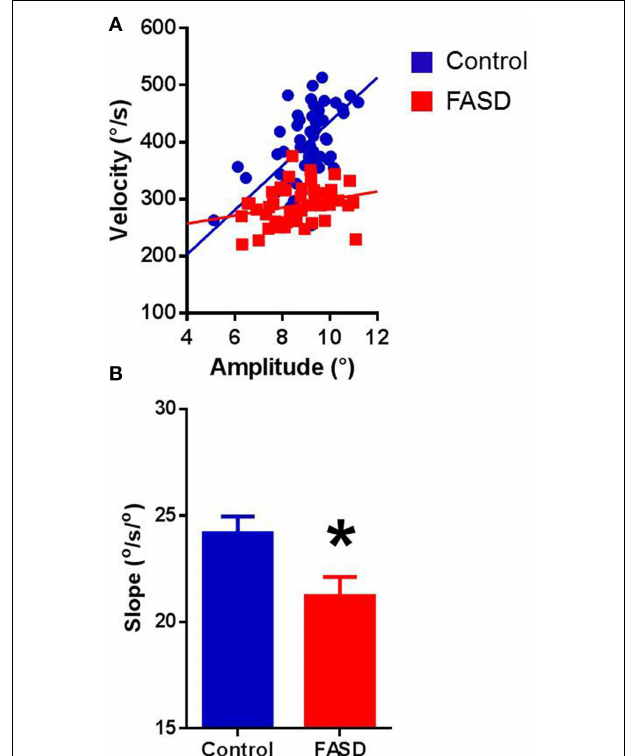
FIGURE 1 | Main sequence relationships. (A) The velocity-amplitude relationship of a 15-year-old control participant and 15-year-old FASD participant. (B) Data for participants in the FASD group ( n = 71 ) shown in red and the control group ( n = 113 ) shown in blue. The slope of the velocity-amplitude relationship was significantly lower in the FASD group. Control is shown in blue and FASD is shown in red. ∗ p < 0 . 05